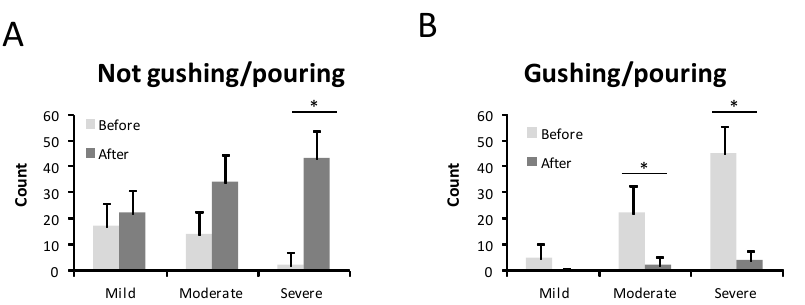
Figure 3. Type of bleeding before and after the treatment in mild, moderate, and severe HHT-ESS patients. ( A ). Not gushing /pouring. ( B ). Gushing /pouring. * p < 0.05.